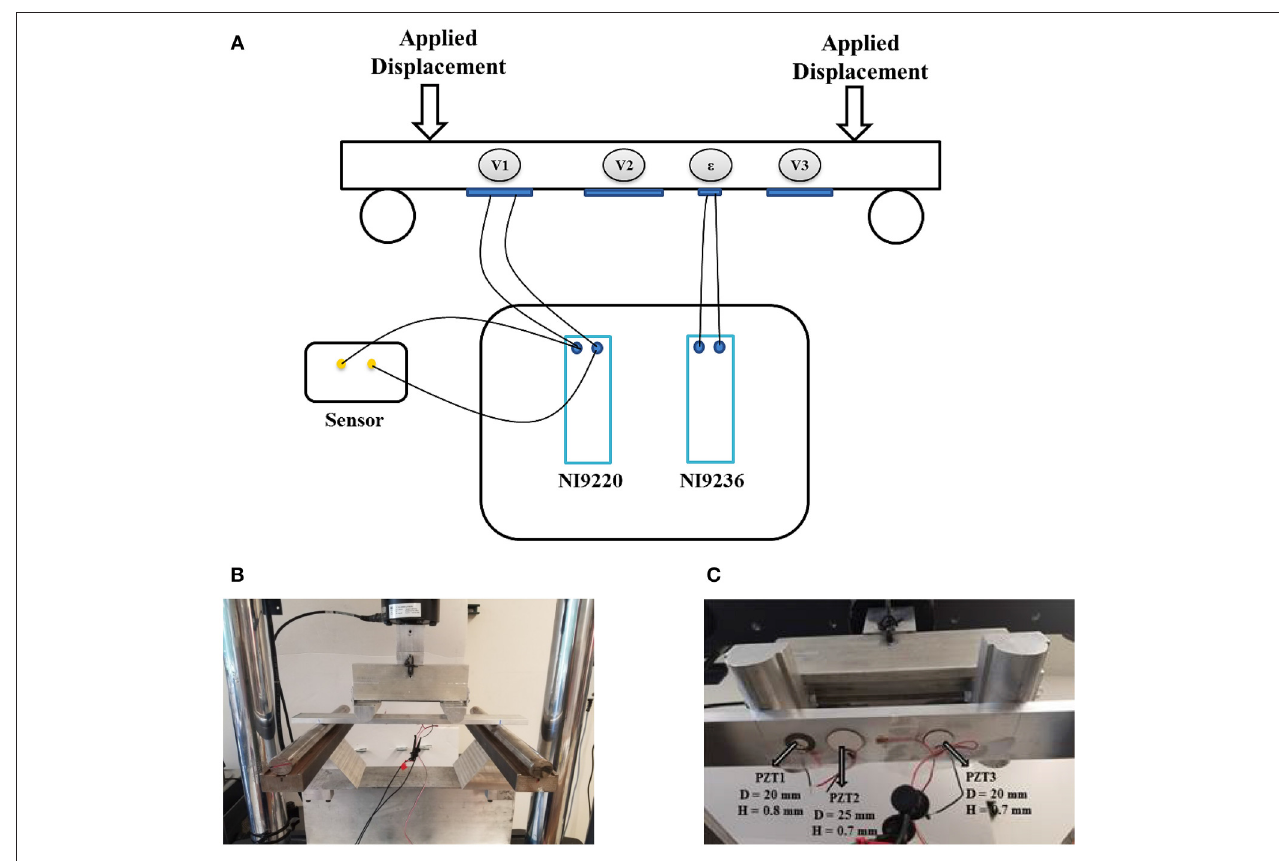
FIGURE 5 | Diagram and images of the test setup used for laboratory validation. (A) A diagram depicting the four-point bending test, with piezoelectrics affixed to the bottom of a plate. The voltage response is measured using National Instruments devices. (B) The picture of our actual apparatus. (C) Close-up of the affixed